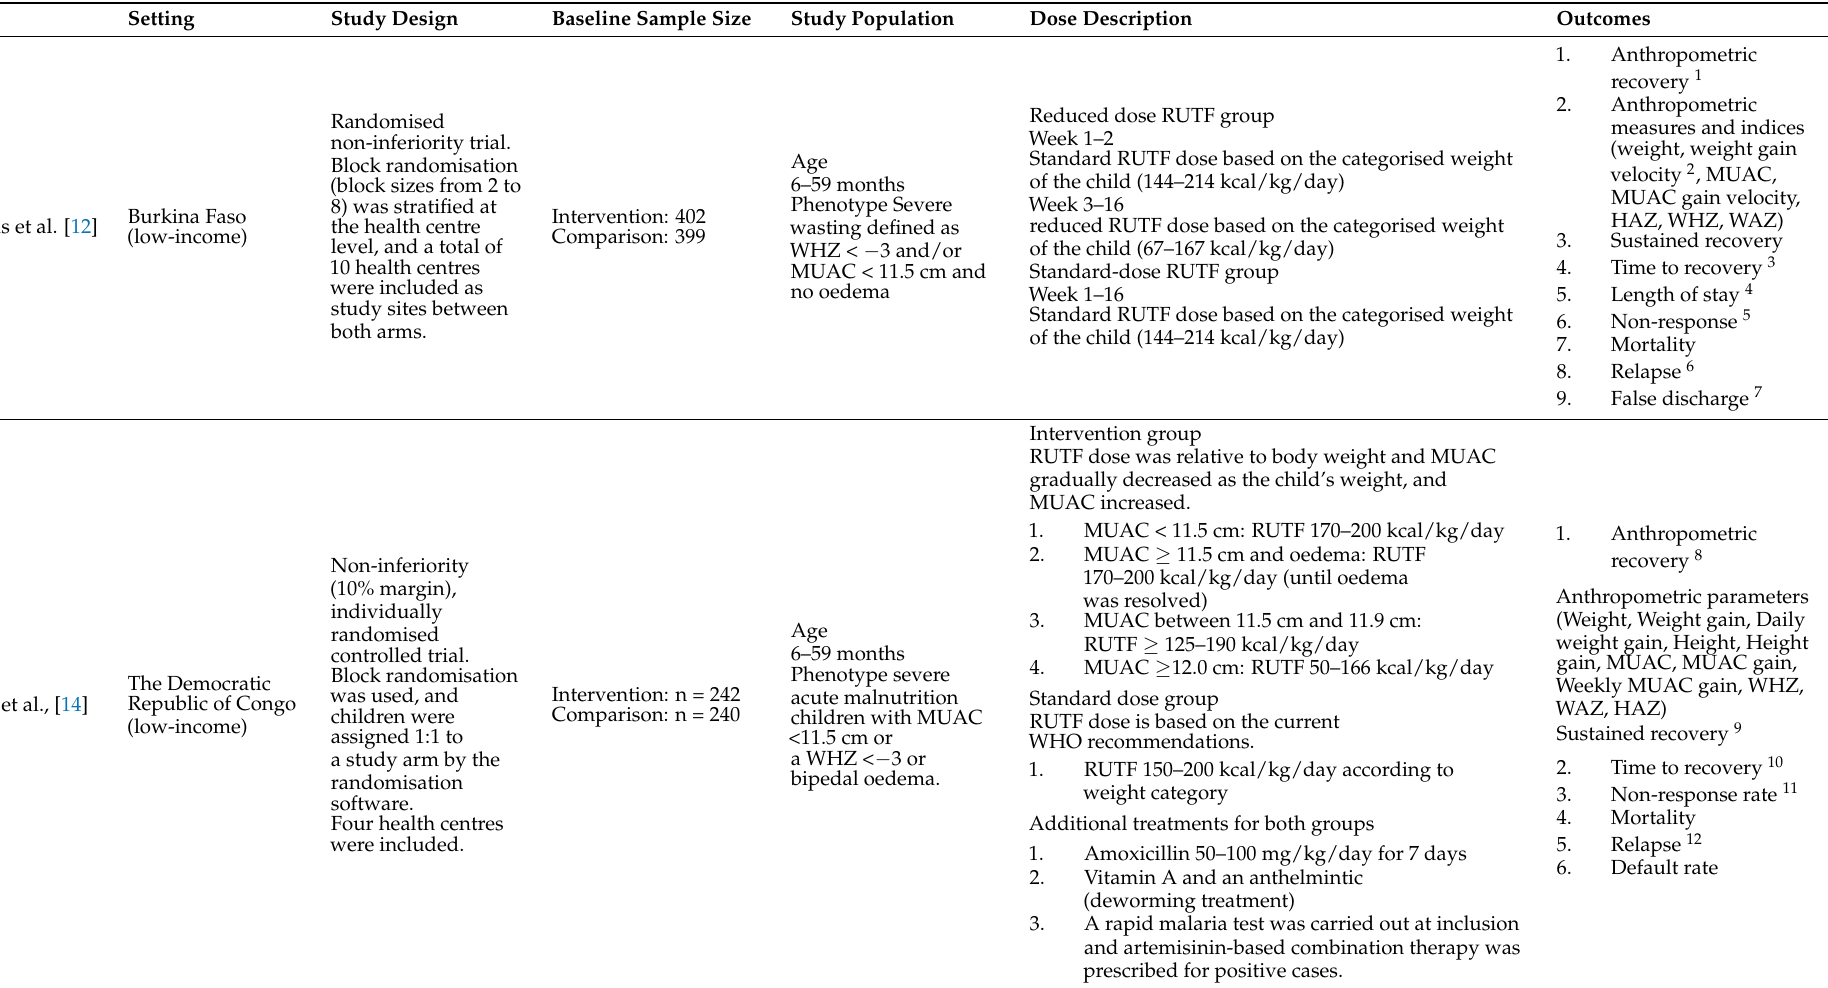
Table 1. Characteristics of studies included in a systematic review of varying doses and dose duration of RUTF for the treatment of severe wasting and/or oedema in children aged 6–59